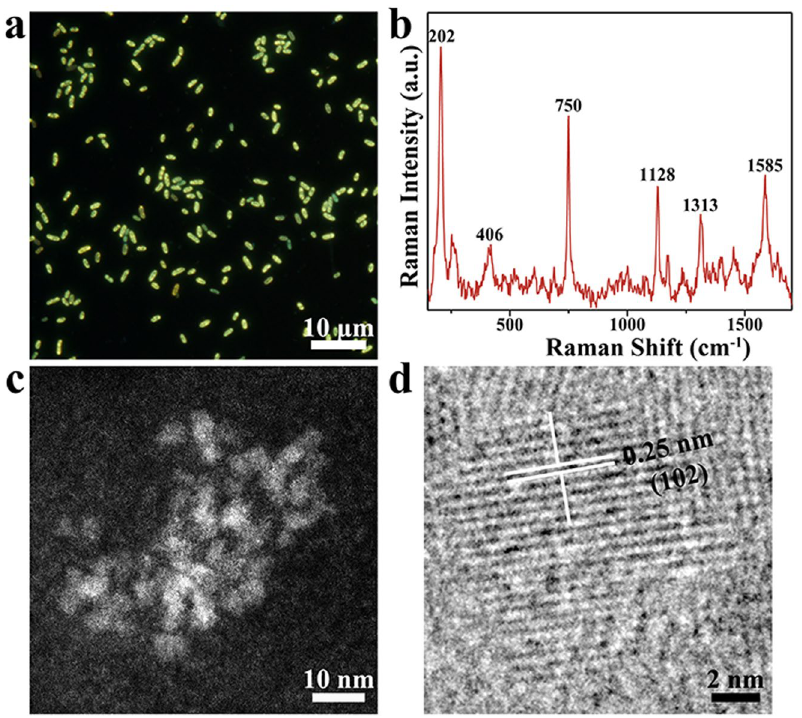
Figure 1. Characteristics of CdSe QDs in Shewanella onedensis cells. ( a ) Fluorescence image. ( b ) In - situ Raman spectrum (excited at 532 nm) shows characteristic peaks of QDs and cytochrome c. ( c ) HAADF-STEM and ( d ) HRTEM images of the purified CdSe